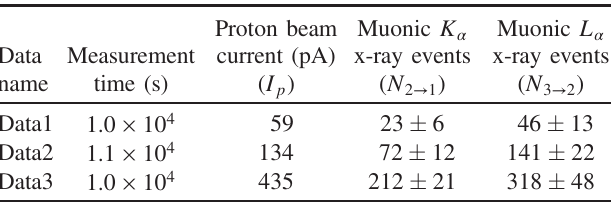
TABLE II. Data sets for muonic x-ray measurements with different proton beam